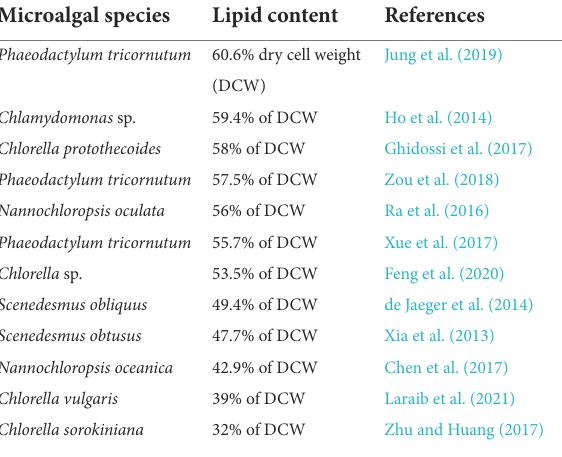
TABLE 1 Selected species of microalgae accumulate lipid for biofuel